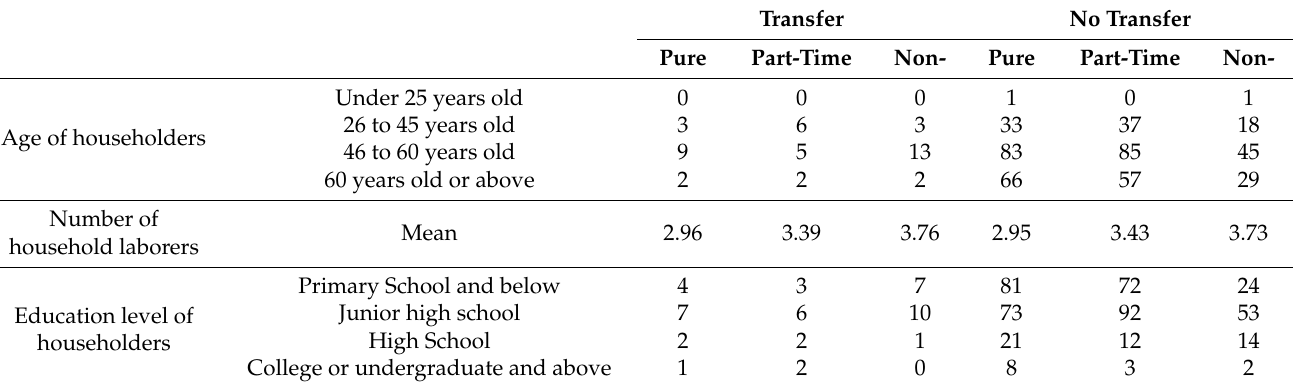
Table 4. Forestland transfer and the characteristics of agricultural